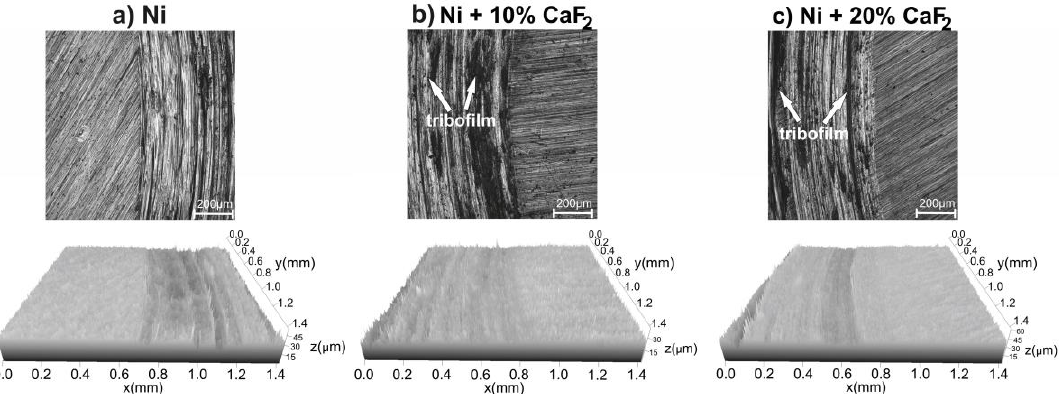
Figure 9. Stereometrics profiles of counter-specimens mated with produced sinters, after wear test at 600 °C.